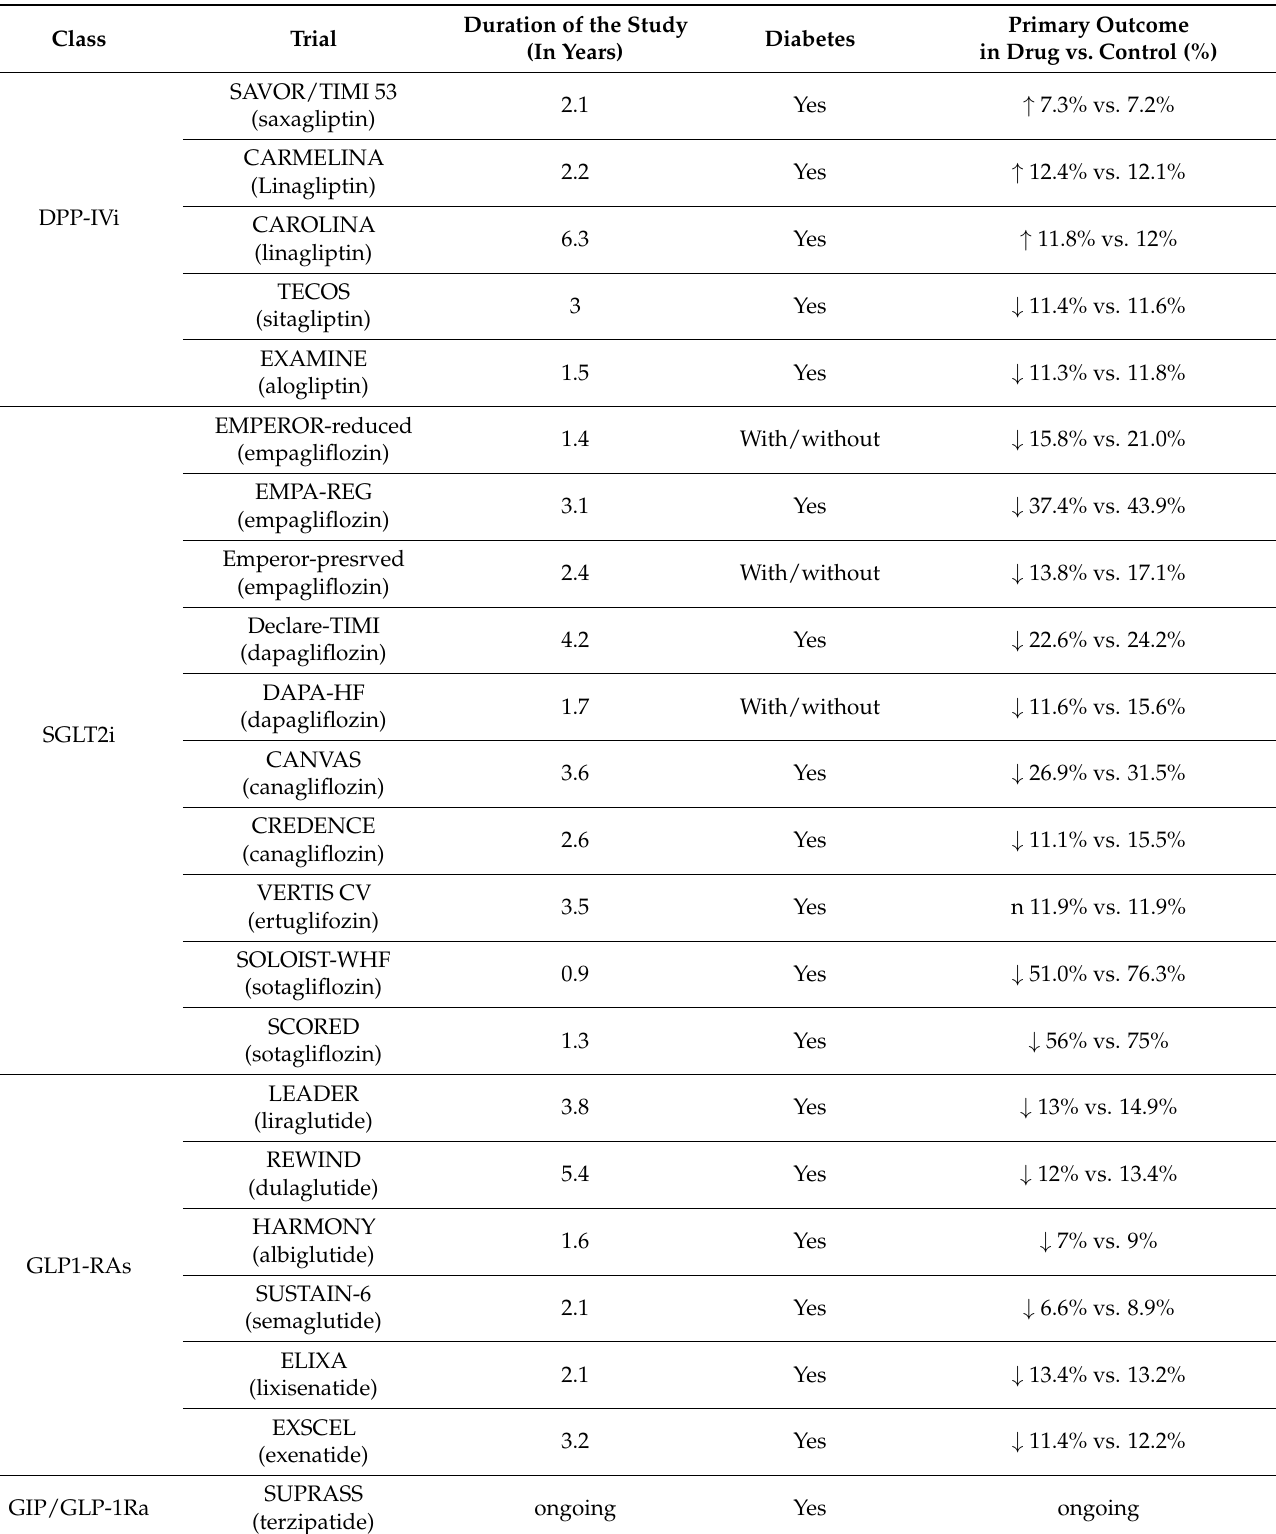
Table 2. Recent pharmacological options and Cardiovascular Outcome Trials: data regarding the duration of the studies, the inclusion of subjects with diabetes, and the primary outcome vs. control group ( ↑ : increased, ↓ :